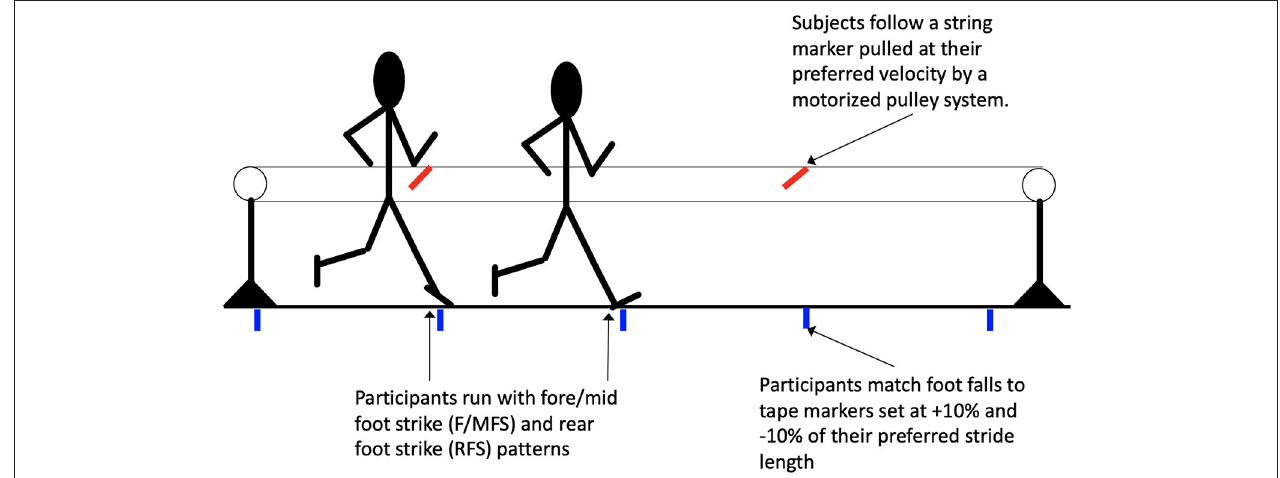
FIGURE 1 | The experimental setup for the stride length (-10% and + 10%) and foot strike (F/MFS and RFS) manipulation conditions.